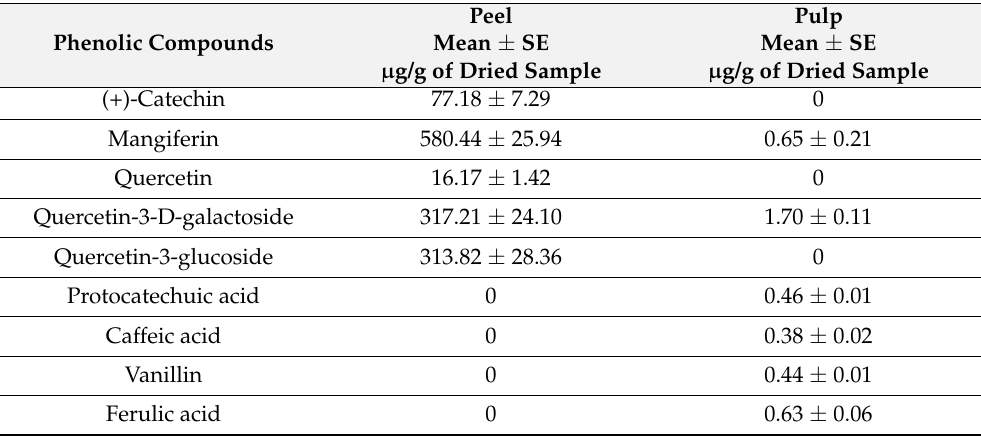
Table 1. Polyphenol concentrations in mango peel and pulp resulting from the “targeted metabo- lomic analysis of plant phenolic compounds” in fruit not exposed to female oviposition activity.